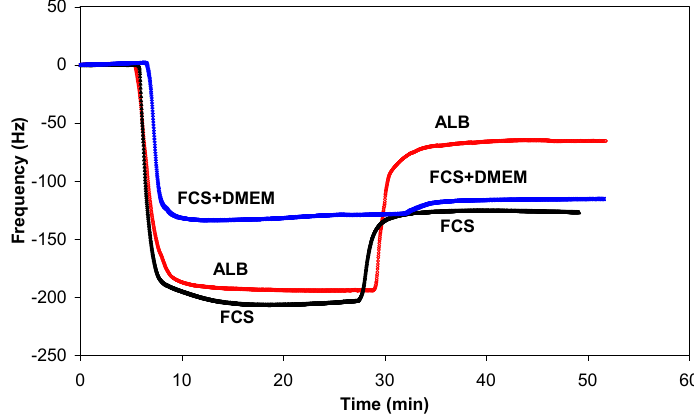
Figure 12. Comparison of the adsorption process of different protein solutions to the oxygen plasma-treated